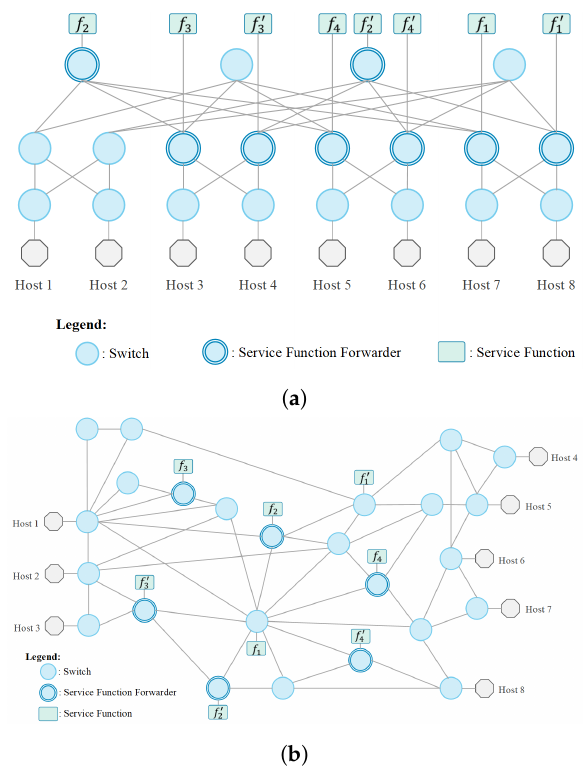
Figure 4. Emulated network topologies in Mininet for the performance evaluation of SFC protec- tion mechanisms. ( a ) Emulated three-layer fat-tree data center topology. ( b ) Emulated enterprise network topology based on the AT&T IP backbone network